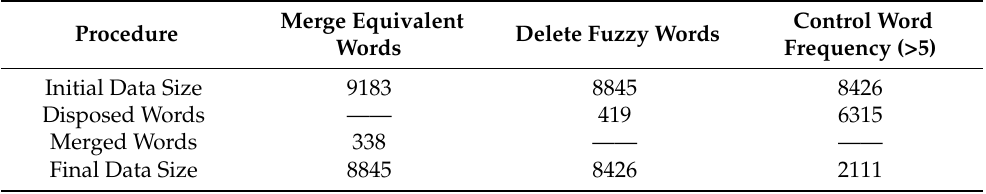
Table 1. Results of the dictionary processing procedure.